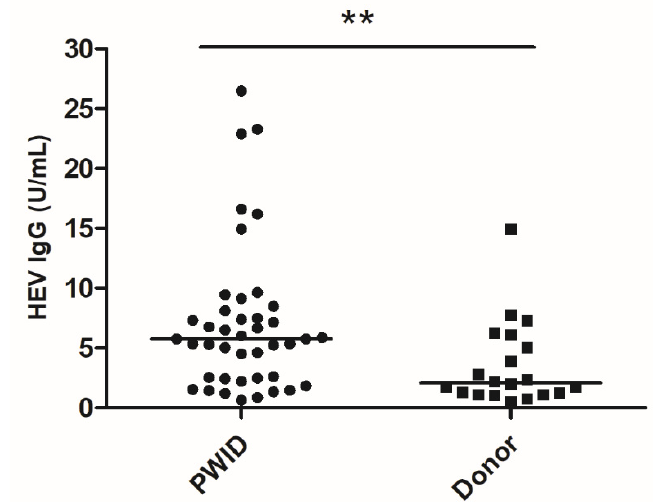
Figure 2. Blood HEV IgG concentrations among PWIDs and organ donors. Bar represents median and (**) indicates statistically significant difference between the median of groups by the Mann–Whitney U test.